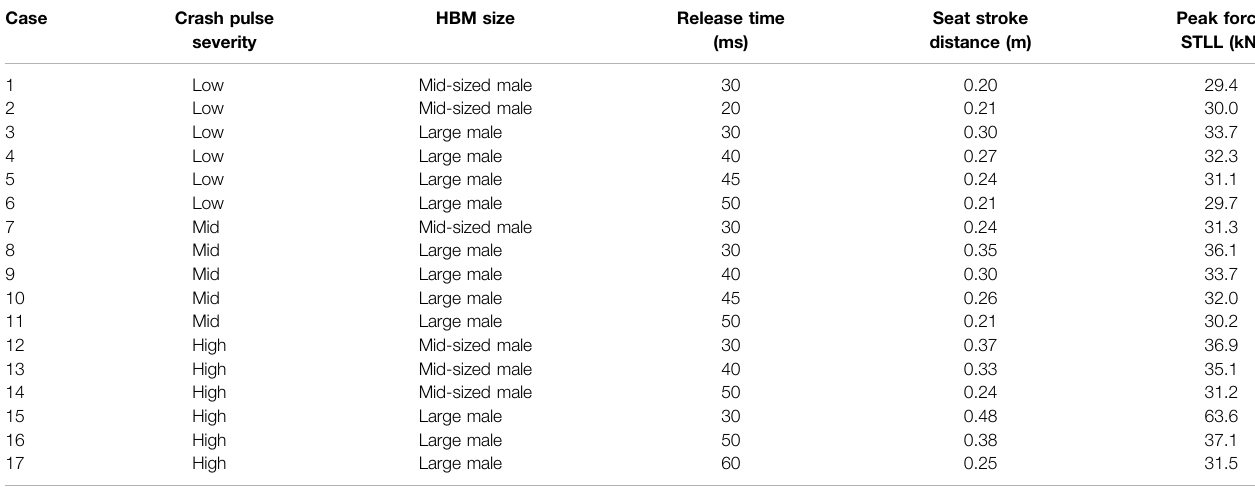
HBM size Release time